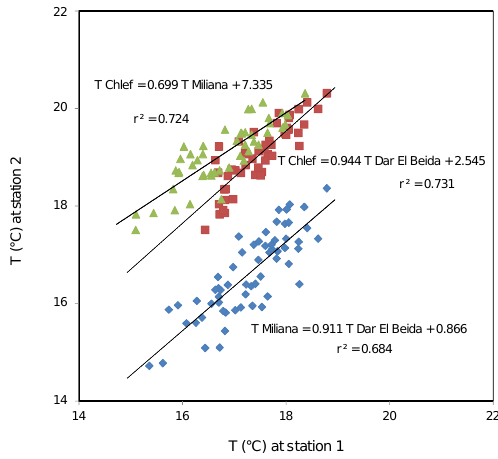
Figure 4. Relationships between mean annual temperatures at the three stations of Dar El Beida, Miliana and Chlef (from